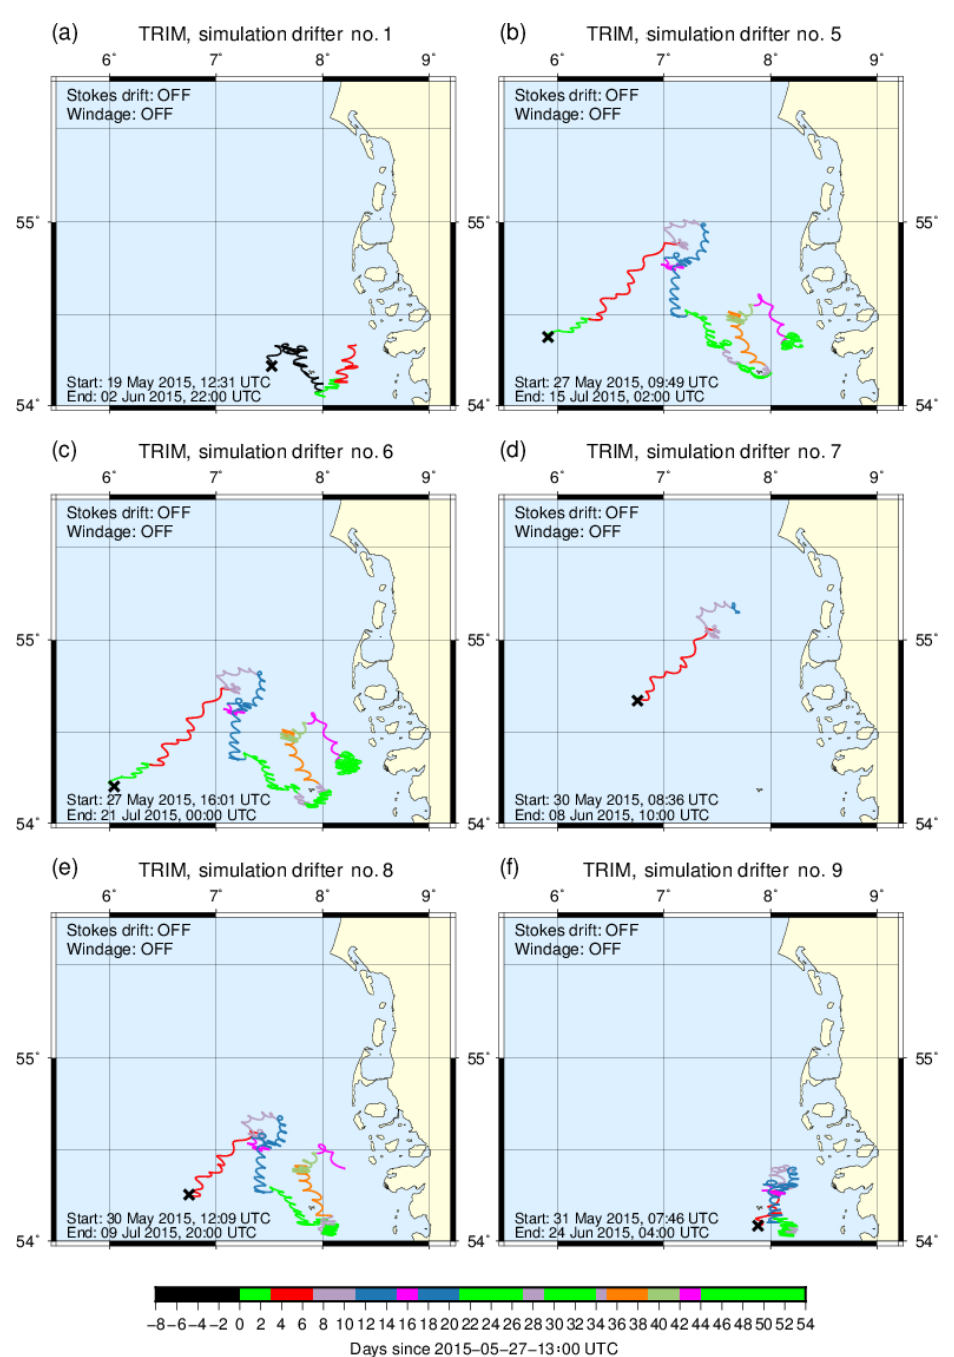
Figure A4. Simulations based on TRIM top-layer currents, disregarding extra effects of winds or waves. Black crosses indicate locations where simulations were